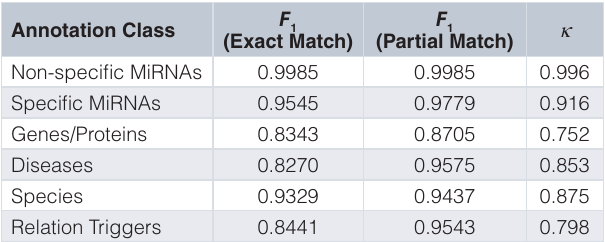
Table 3. Statistics of the published miRNA